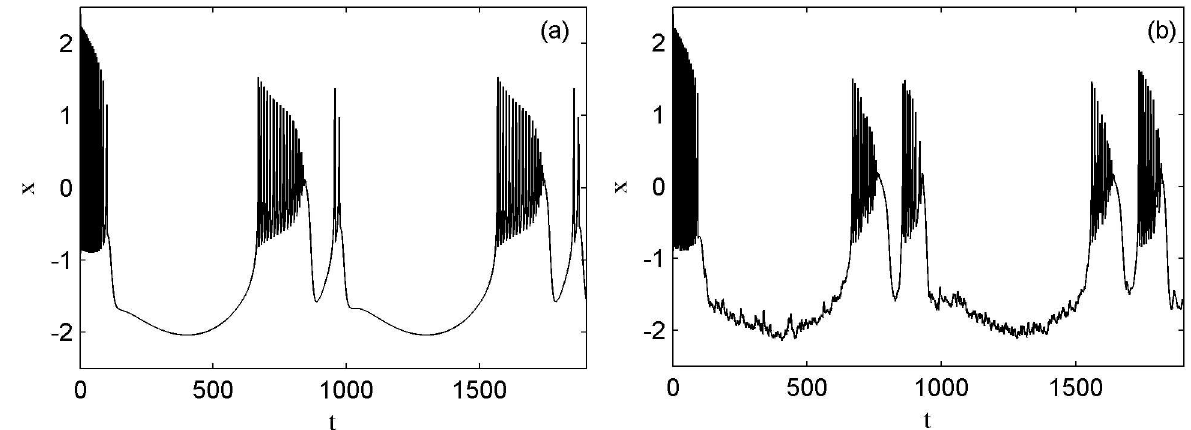
Fig 4. The time series of the membrane potential of neuron under different external radiation-induced magnet flux.